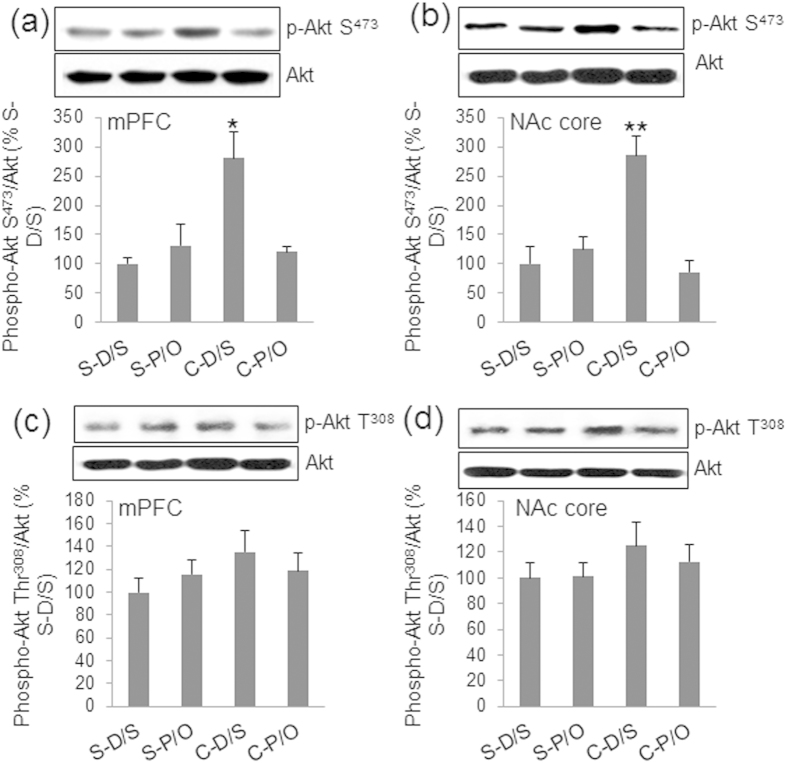
Alterations in the phosphorylation status of Akt in cocaine sensitized rats and its relationship with ILK.(a) Percent densitometric values of phospho-Ser473 Akt to total Akt in the mPFC are in the lower panel; the top panel shows representative Western blots of phospho-Ser473 Akt (p-Akt) and total Akt proteins. (b) Percent densitometric values of phospho-Ser473 Akt to total Akt in the NAc core in the bottom panel; representative Western blots are shown in the top panel. (c) Phosph-Thr308 Akt levels in the mPFC. (d) Phosph-Thr308 Akt levels in NAc core. See Figure 1 for details of the groups. Phospho-Akt protein levels are expressed as percent control where levels for the S-D/S group are set to 100%. *p < 0.05, **p < 0.01, C-D/S from all other groups.